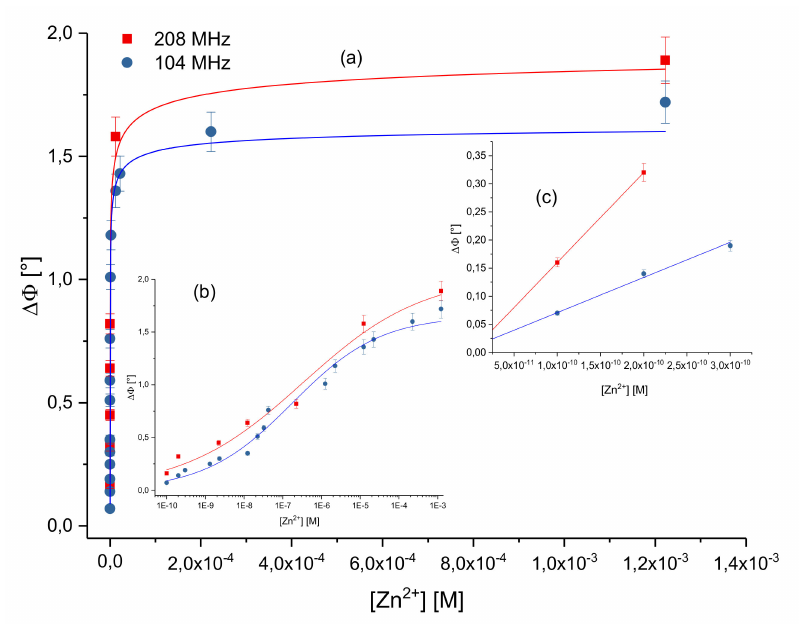
Figure 12. Phase-shift variations ( ∆Φ ) versus cumulative Zn 2 + concentration for 104 and 208 MHz SAW sensors functionalized with TDP-AN molecules ( a ) in linear scale; ( b ) in logarithmic scale; the red and blue lines correspond to the best fit of experimental data according to the Hill model. ( c ) Slope at the origin of phase / concentration curves for both 104 and 208 MHz SAW